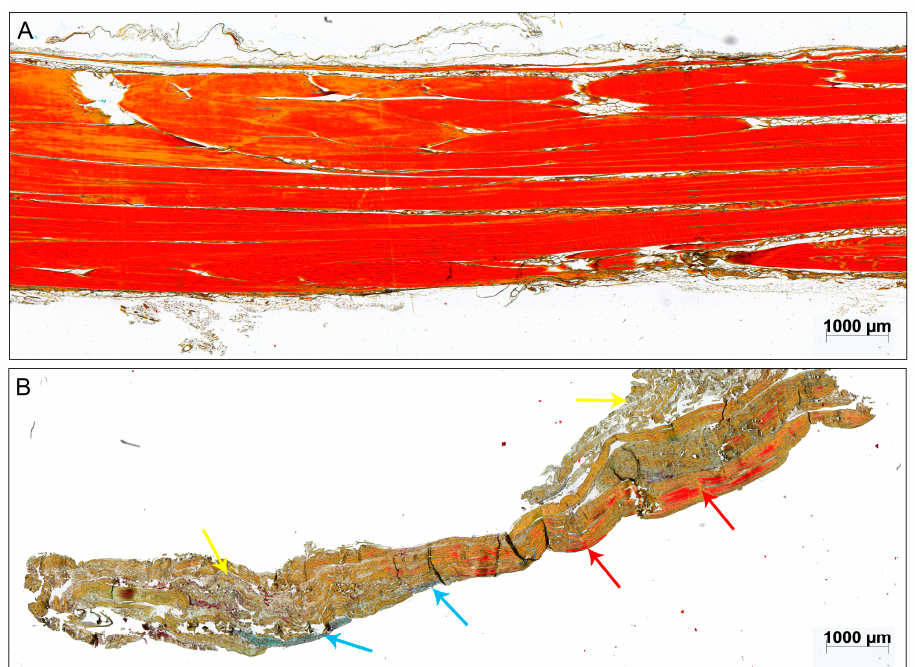
Figure 1. Exemplary sample of ( A ) an intact cadaveric tendon and ( B ) a 3-days-old acute ruptured Achilles tendon stained with Movat Pentachrome (MP). The red color of the otherwise brownish collagen fibers indicates mature collagen [18]. The red arrows point to intact parallel-aligned collagen fibers in the ruptured tendon. The blue arrows point to glycosaminoglycan (GAG)-rich areas and the yellow arrows mark unorganized tissue. Scale bar: 1000 μ m.